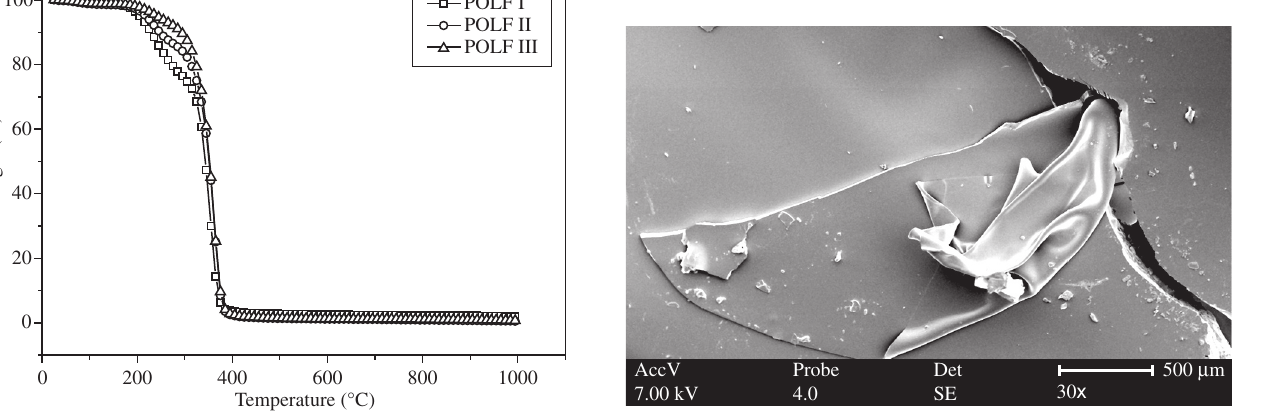
Figure 4. Thermogravimetric analysis curves from POLF series. Figure 6. Scanning electron microsocopy from POLF II sample.